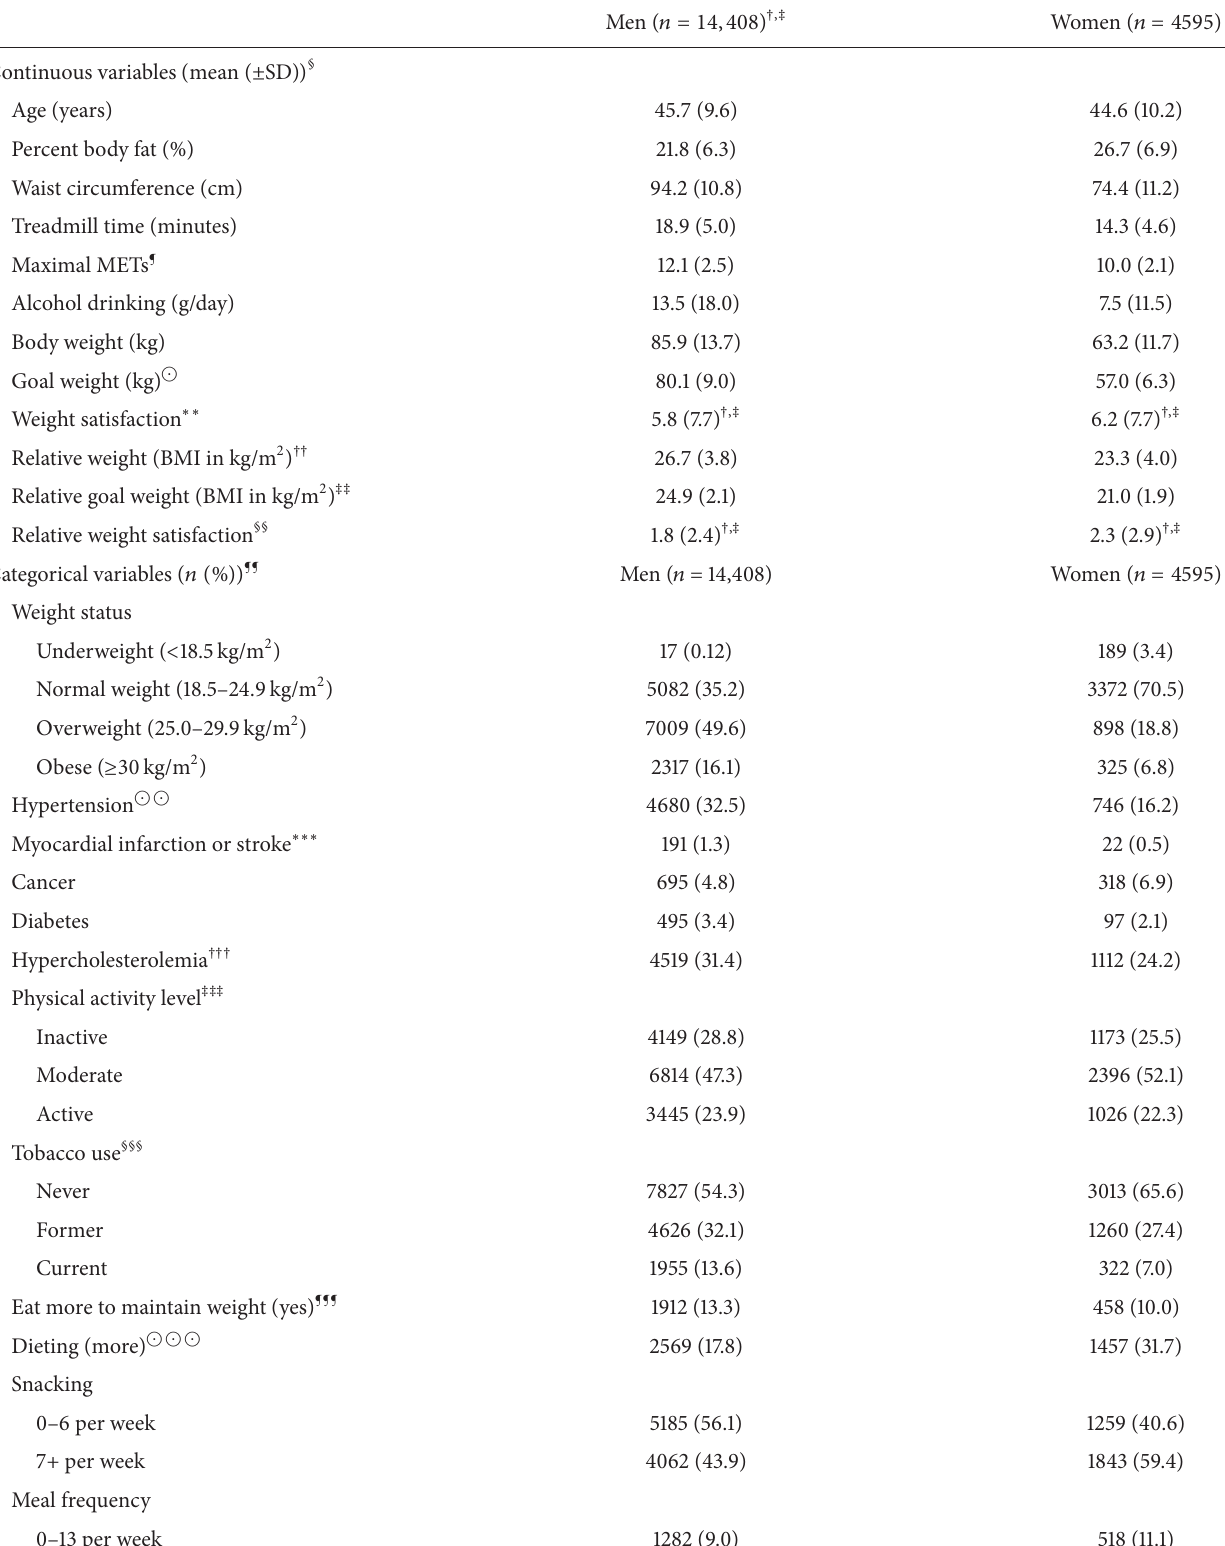
Table 1: Participants’ characteristics by gender, Aerobics Center Longitudinal Study, 1987–2002 ( 𝑛 = 19, 003 ) ∗